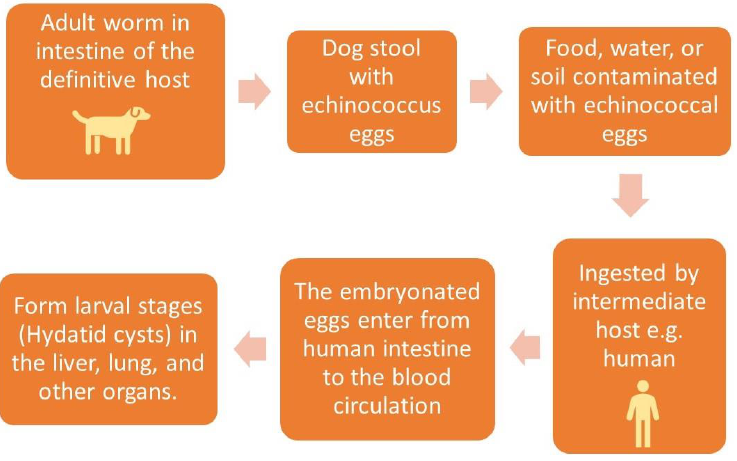
Figure 1. Method of human infection with Echinococcus granulosus.